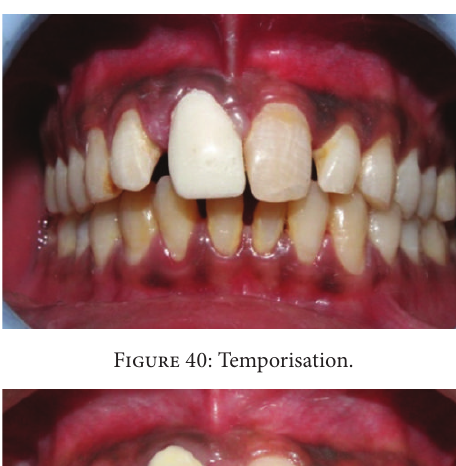
Figure 39: Tooth preparation.